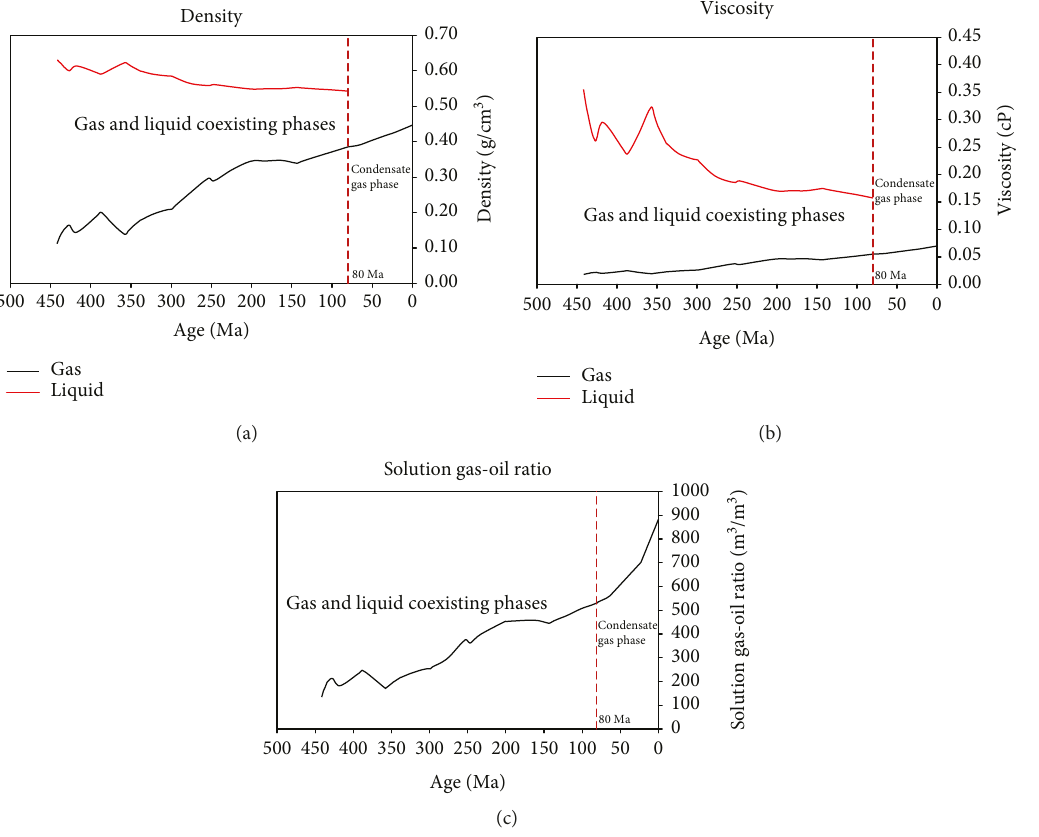
Figure 10: The evolution of fl uid density, viscosity, and solution gas-oil ratio (GOR) under ideal